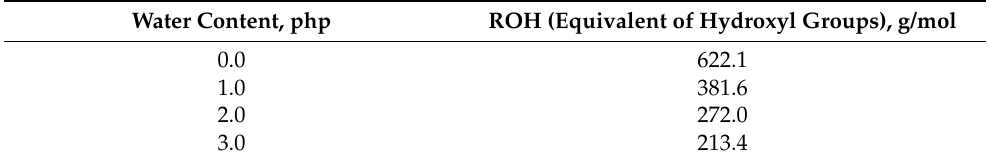
Table 1. Characteristics of polyol